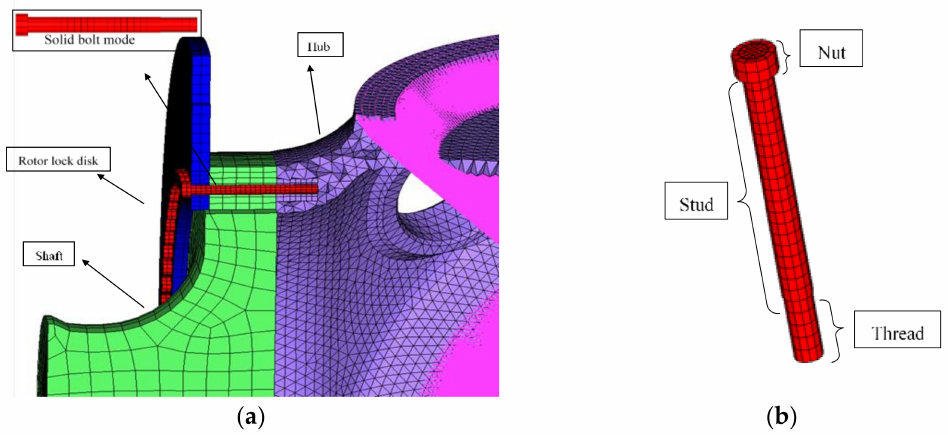
Figure 6. ( a ) Cross section of the finite element model; ( b ) Solid bolt model.